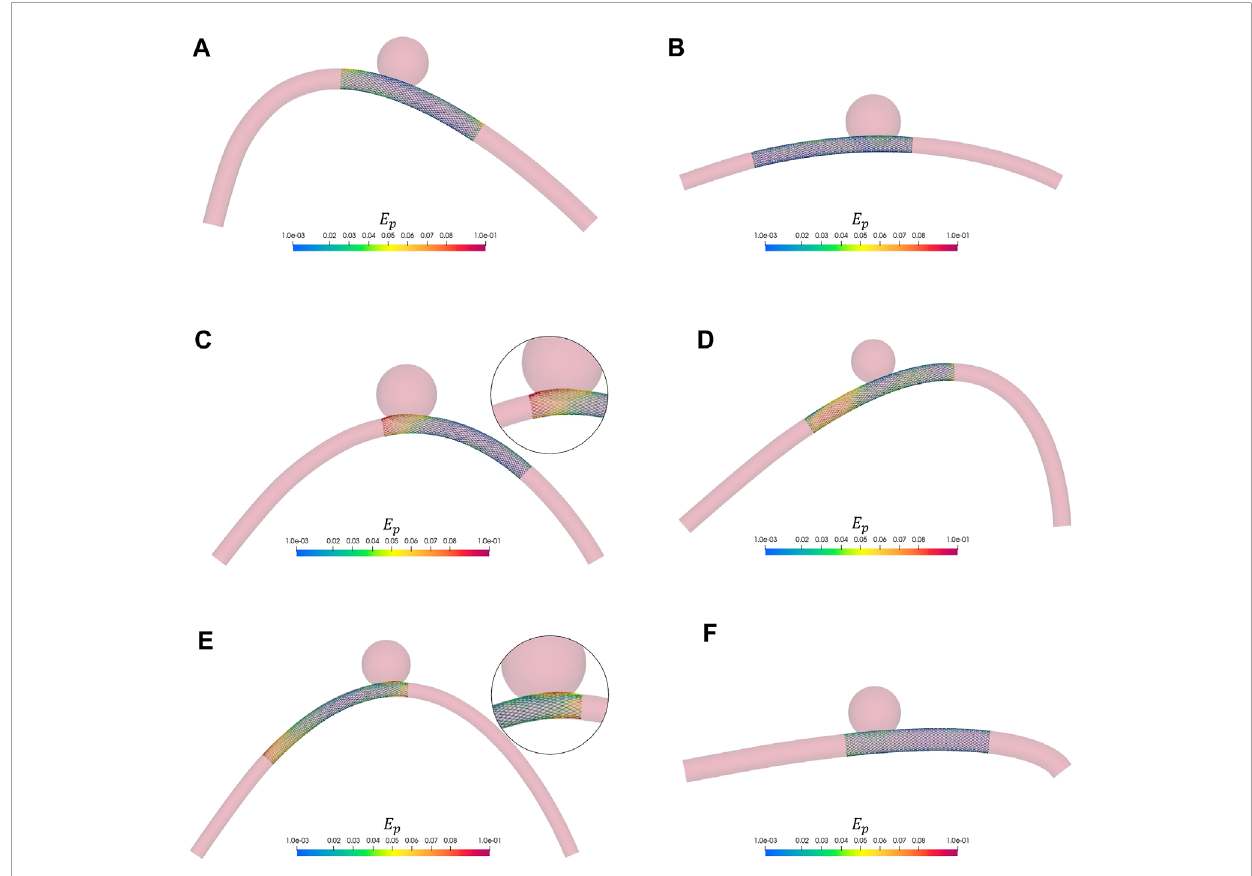
FIGURE 11 Six examples from the test dataset. The nodal absolute error E p between HF and predicted solution is shown as a colourmap. As comparative scale, for each solution we reported the diameter of the vessel and the aneurysm. The wire thickness is magnified ( 2 ×) to better visualize the stent. (A) D v = 3.3 mm, D a = 8.24 mm. (B) D v = 2.62 mm, D a = 8.84 mm. (C) D v = 2.9 mm, D a = 9.68 mm. (D) D v = 2.84 mm, D a = 7.08 mm. (E) D v = 2.38 mm, D a = 7.86 mm. (F) D v = 3.62 mm, D a = 8.4